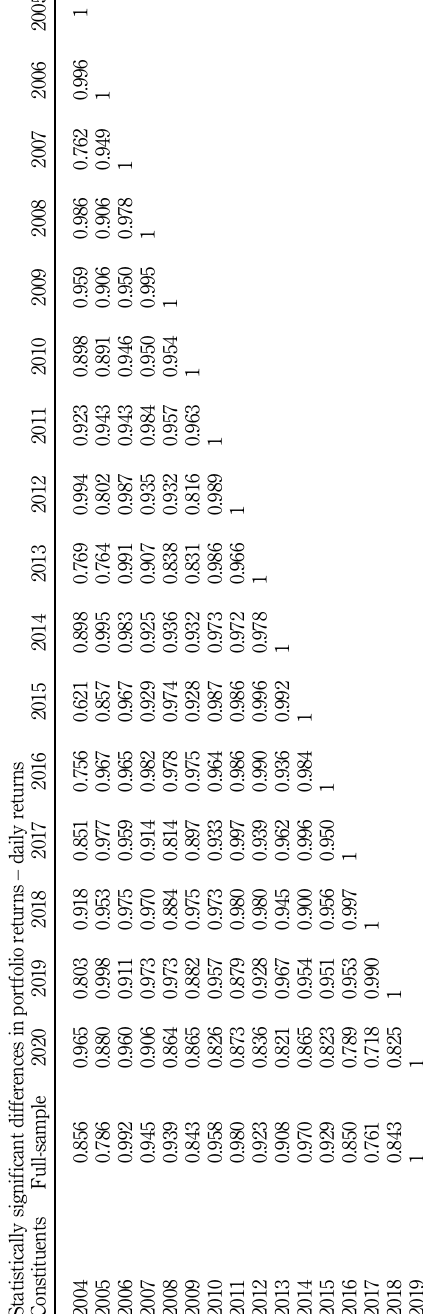
Table 1. p -valueresultsof t -tests showing statistically significant difference in portfolio returns using a constant portfolio with weights as taken from year shown in the first column across individual years and full-sampleasshownin the first